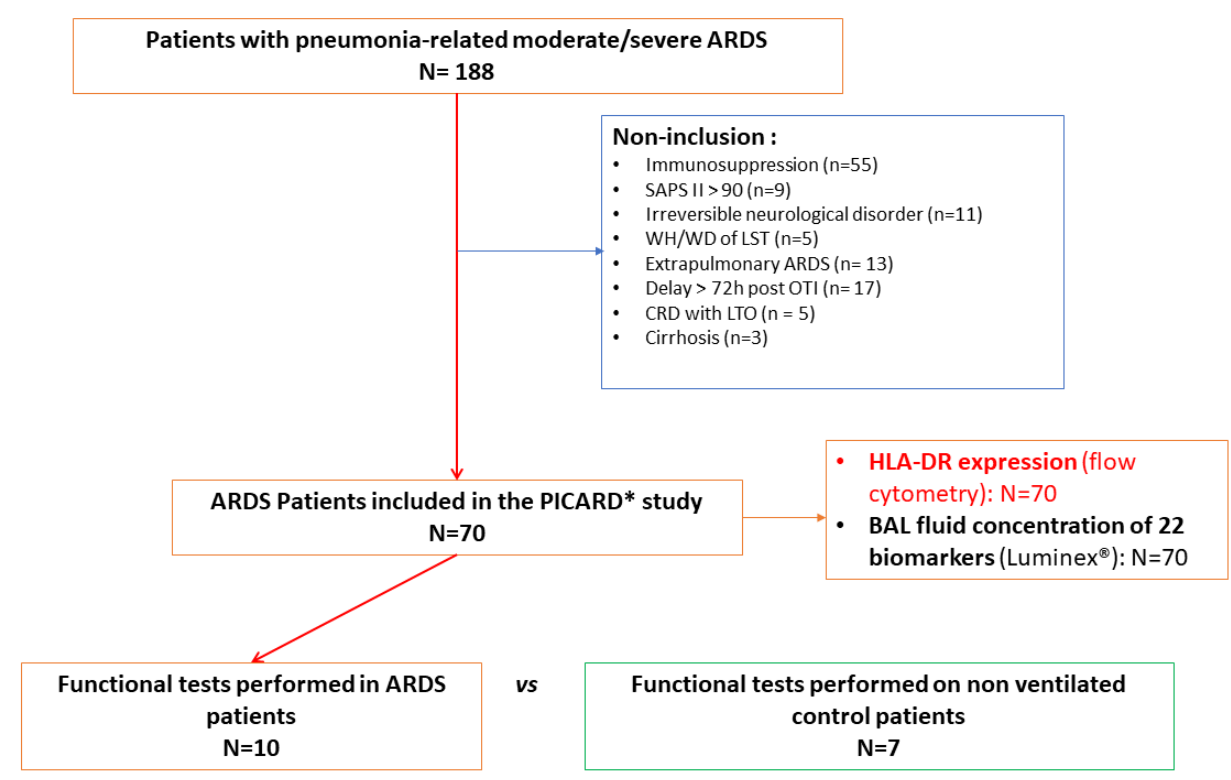
Figure 1. Flow chart of patients with pneumonia-related moderate/severe acute respiratory distress syndrome (ARDS) included in the study. BAL: broncho-alveolar lavage; CRD: chronic respiratory disease; LTO: long term oxygenotherapy; OTI: oro-tracheal intubation; WH/WD of LST: withholding/withdrawal of life-sustaining therapies; * Patients included in the PICARD study are comprehensively described elsewhere [6].